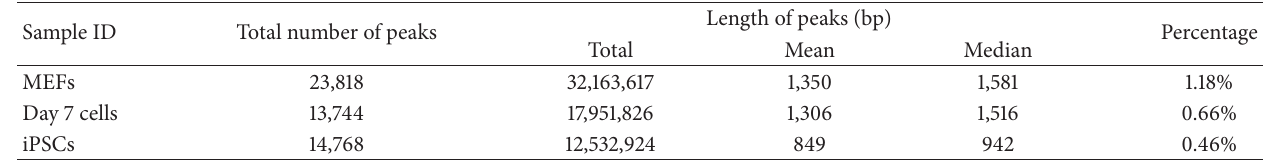
Table 3: Output of peaks from H2A.Z ChIP-Sequence.